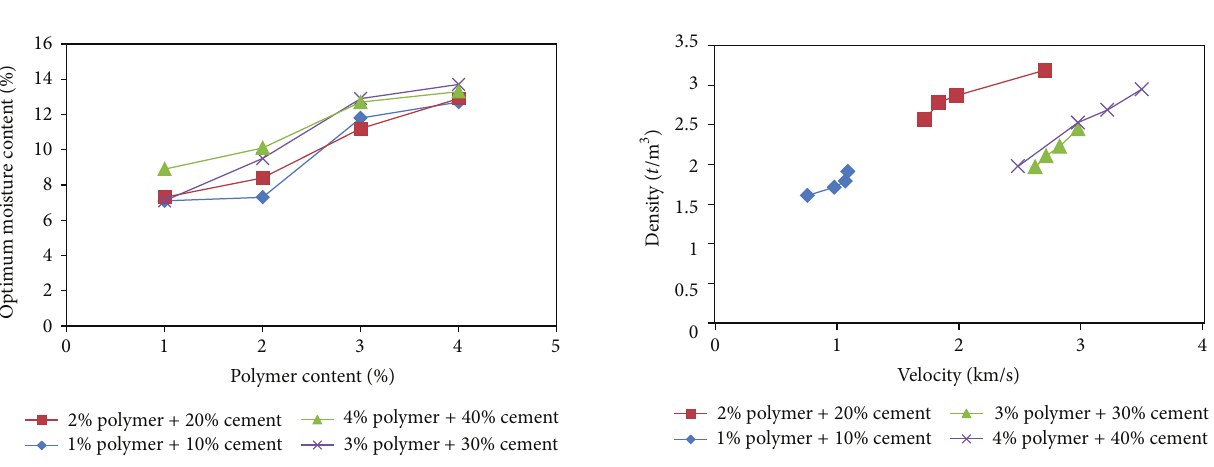
Figure18:Ultrasonicpulsevelocitytestprocedureindryconditions for 14 days.